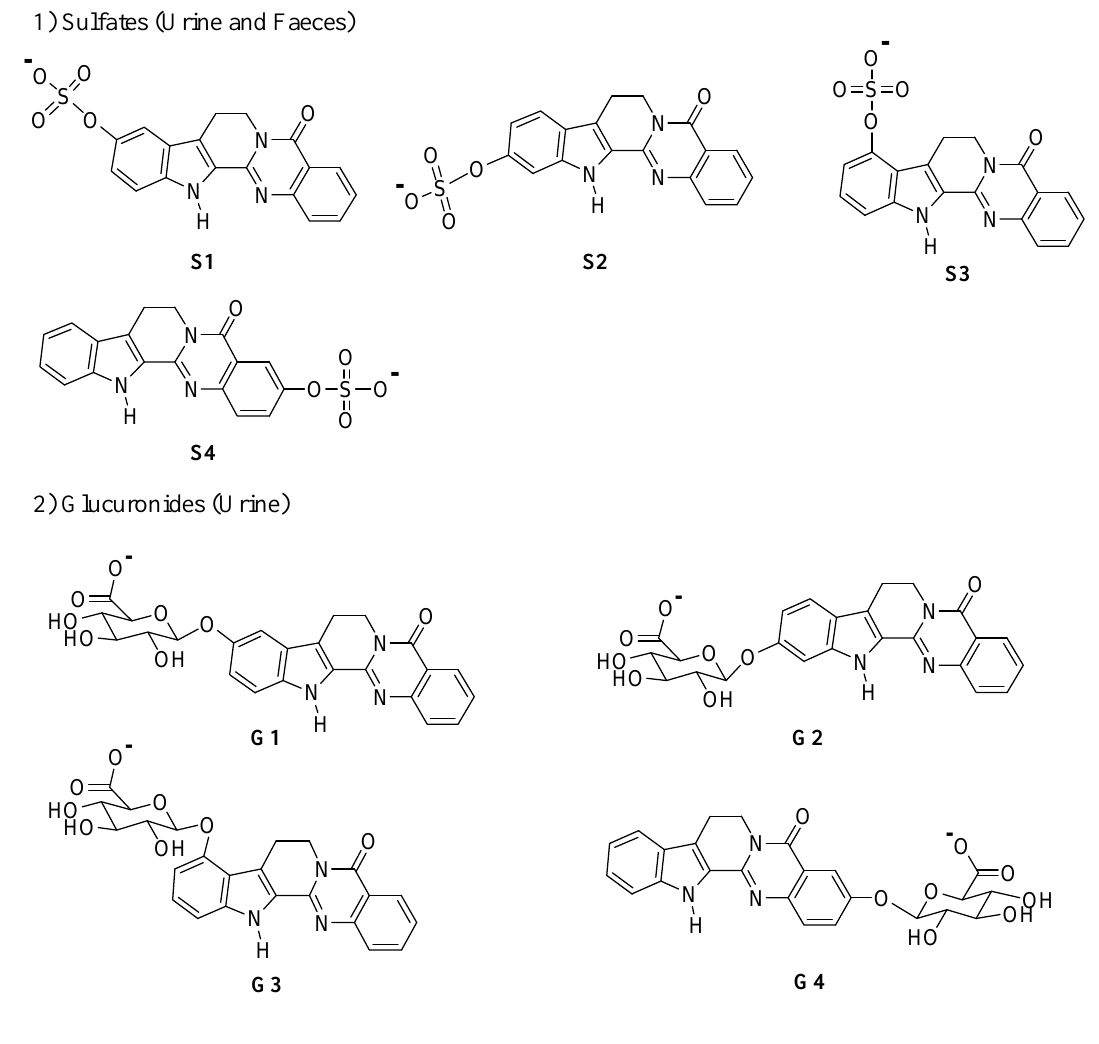
Figure 3. In vivo Phase II metabolites of